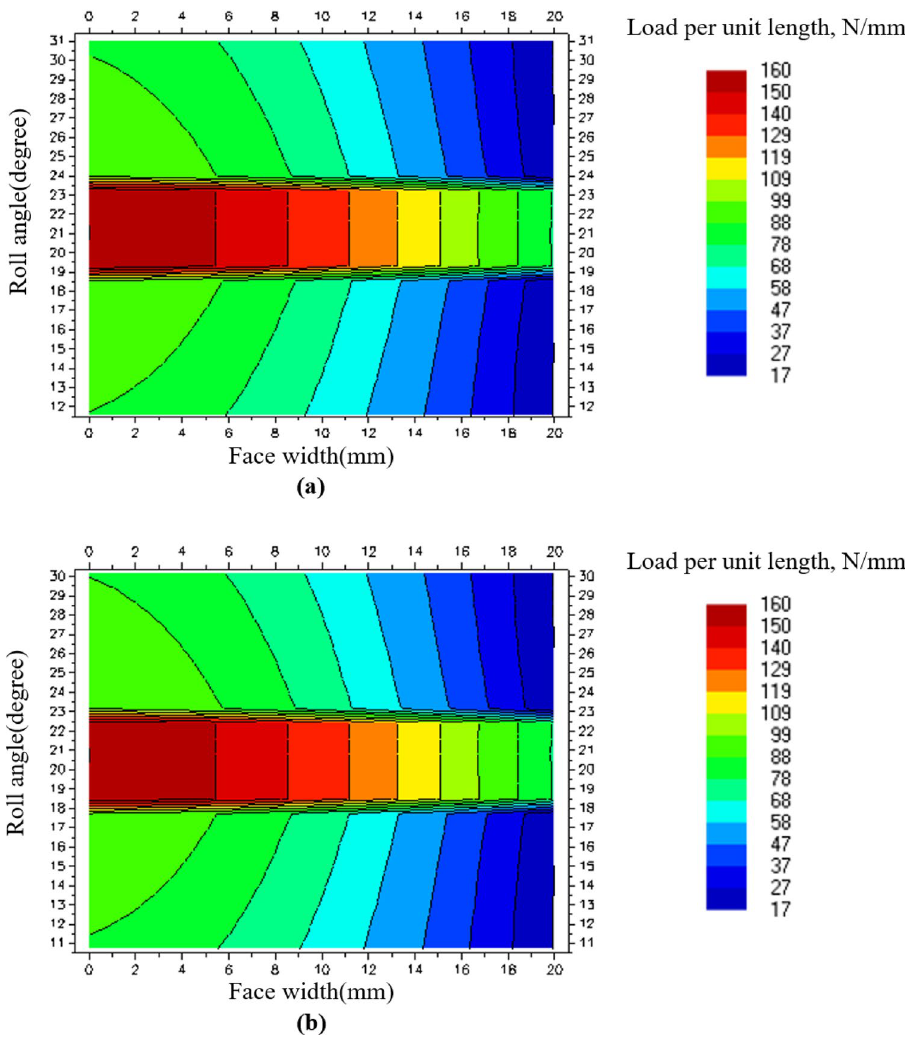
Figure 8. Face load distribution of SGS 1 on load level 8 after micro-geometry modification: ( a ) Pinion contact pattern and ( b ) gear contact